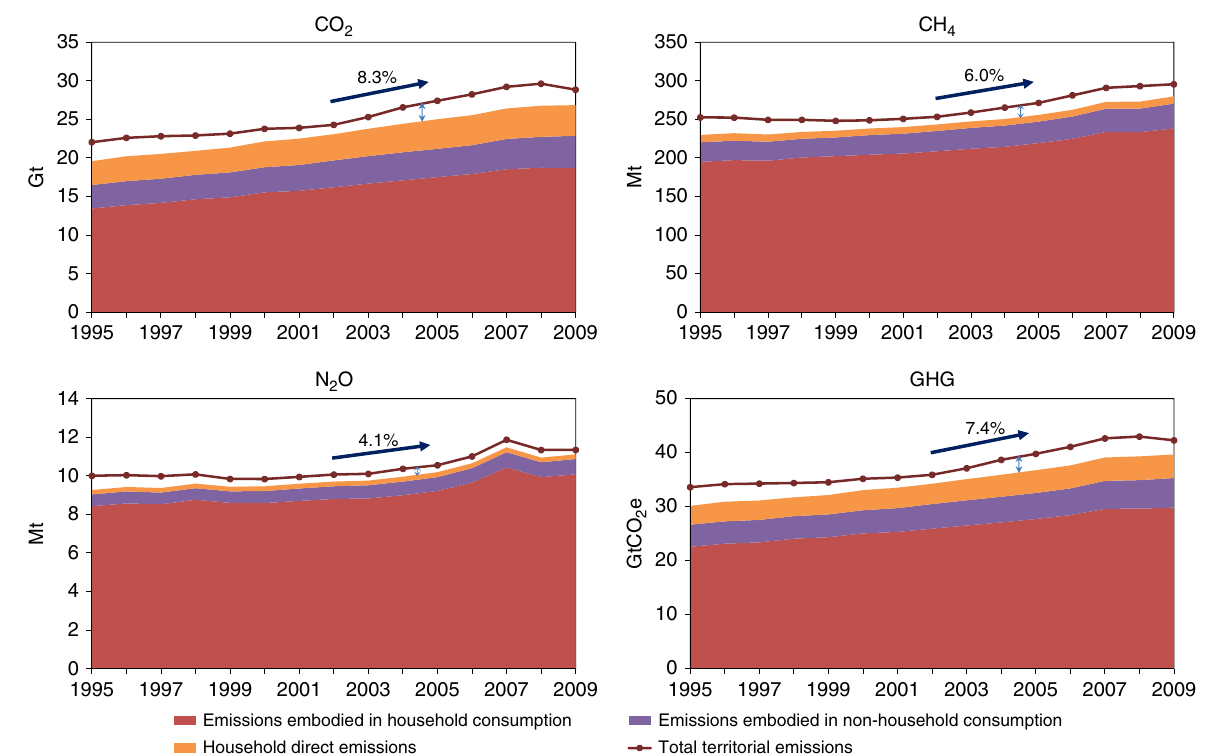
Fig. 2 Territorial emissions and dynamic footprint of the world. The global dynamic footprint is smaller than the direct territorial emissions during the period and the gap is more remarkable for CO 2 than the other two GHG types. The dynamic footprint is the aggregation of household direct emissions, emissions embodied in fi nal household consumption, and emissions embodied in fi nal non-household consumption. GHG emissions are calculated as the sum of CO 2 , CH 4 , and N 2 O emissions based on the relative global warming potentials of 100 years with climate change feedback 58 , which are 1, 34, and 298, respectively